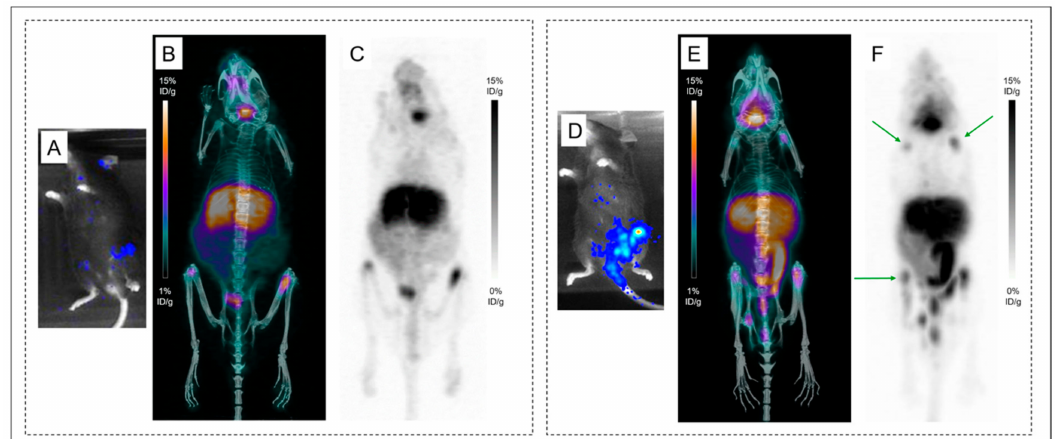
Figure 6. Altered contrast in the disseminated model imaged with 89 Zr-DFO-9E7.4 at 24 h post-injection. Bioluminescence imaging ( A ) revealing lesions in both femurs. Maximum intensity projections of PET and CT imaging with 89 Zr-DFO-9E7.4 at 24 h post-injection (PI) ( B ) and maximum intensity projections of PET imaging with 89 Zr-DFO-9E7.4 at 24 h PI ( C ) showing uptake in both femurs (Mouse 16). Bioluminescence imaging ( D ) revealing lesions in the sacrum, left femur and both iliac wings. Maximum intensity projections of PET and CT imaging with 89 Zr-DFO-9E7.4 at 24 h PI ( E ) and maximum intensity projections of PET imaging with 89 Zr-DFO-9E7.4 at 24 h PI ( F ) showing uptake in the sacrum, left femur and both iliac wings (Mouse 17). Multiple false-positive osseous foci were also observed (indicated by green